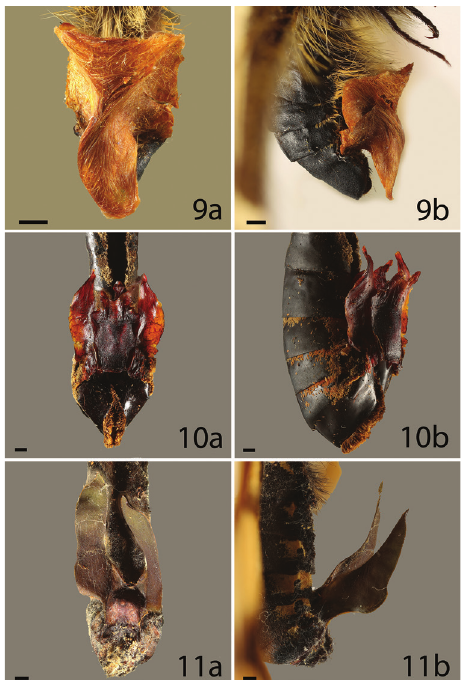
Figures 9–11. Sphragis of butterfly species, a ventral b lateral, category of the sphragis in parenthesis. 9 L. puziloi (4) 10 Cressida cressida (4) 11 Euryades duponchelii (4). Scale bar = 1 mm.